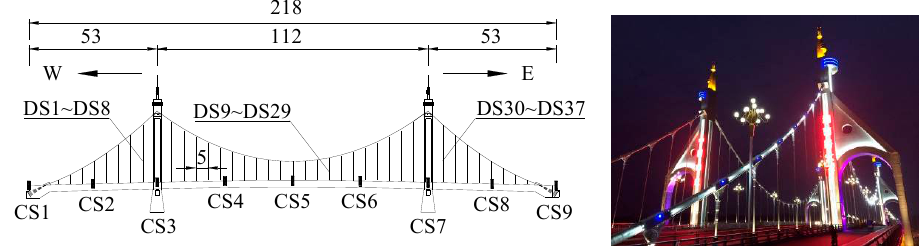
Figure 1. Global layout of the Hunan Road Bridge (Unit: m).